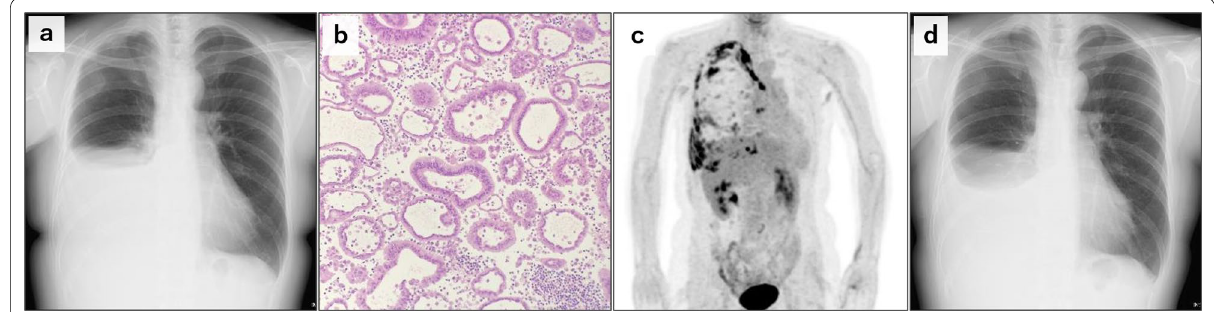
Fig. 1 Cytology and imaging of carcinomatous pleurisy. a Chest X-ray at the time of recurrence diagnosis. b Tubular-forming metastatic breast cancer cells in pleural effusion. c Positron emission tomography scan at the time of recurrence diagnosis. d Chest X-ray 1 month after the initiation of targeted